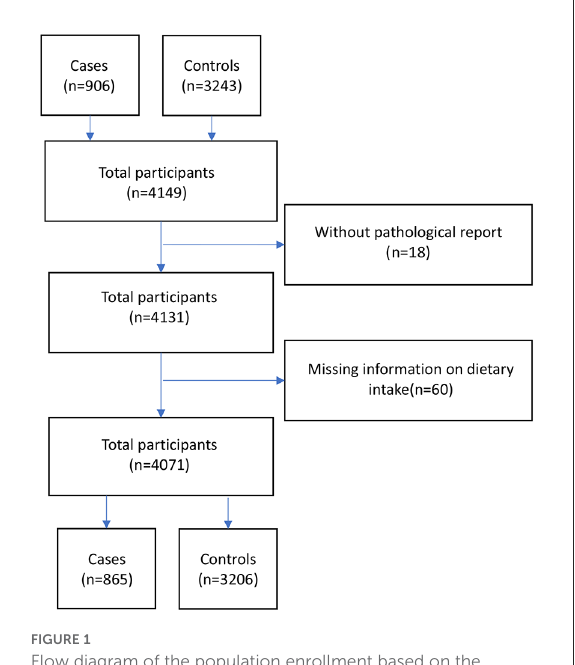
FIGURE1 Flow diagram of the population enrollment based on the inclusion and exclusion criteria in IROPICAN